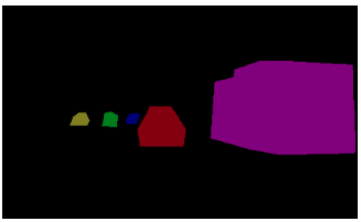
Figure 9. Mask labeling of instance